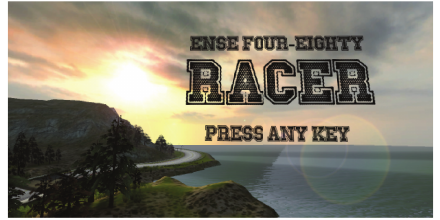
Figure 4: An excerpt of the script developed with the MonoDevelop IDE interface.